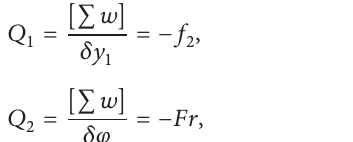
Figure 3: Braking dynamic model of energy